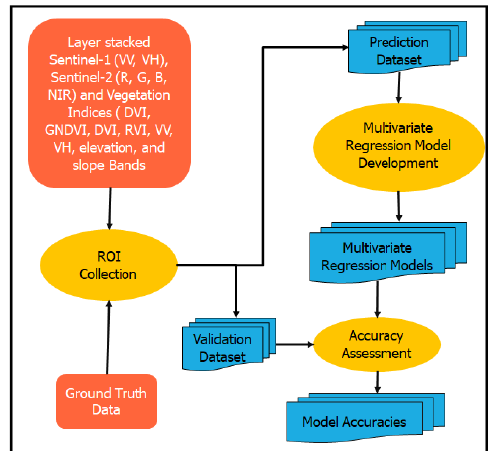
Figure 1 . Steps employed in the development and accuracy assessment of multivariate regression models for Falcata stand age estimation.